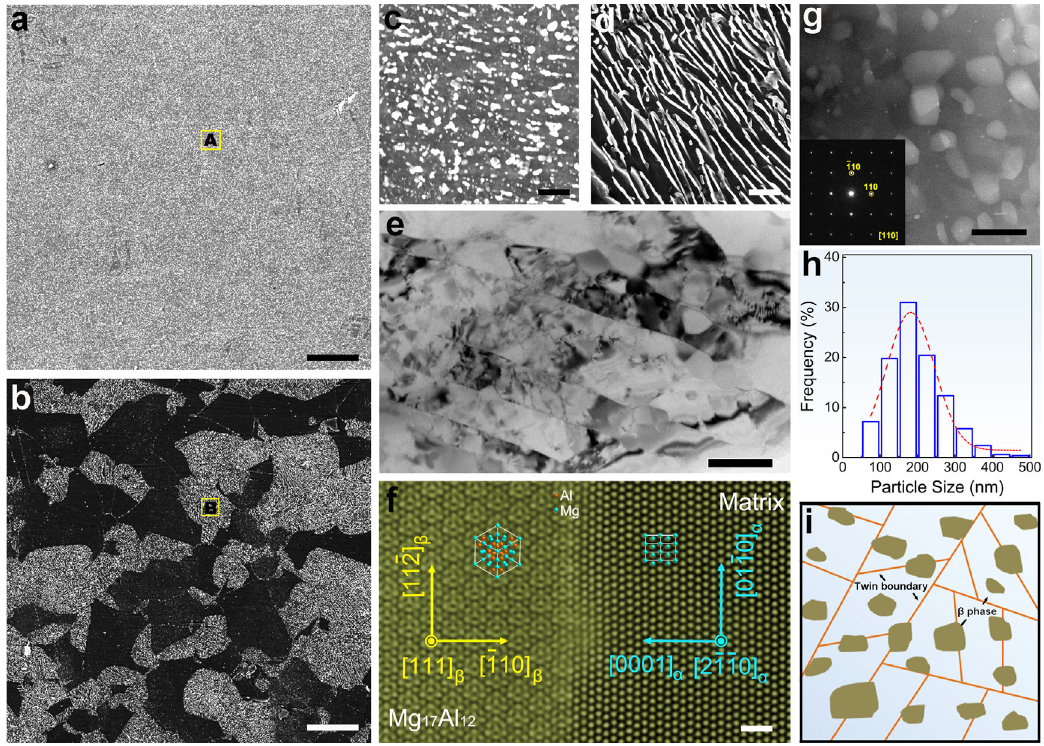
Fig. 2 Microstructure after aging at 180 °C for 24 h. Scanning electron microscopy (SEM) images of ( a ) Aged UFT-4 and ( b ) AZ80-T6, scale bar = 20 μ m in ( a ) and ( b ); ( c ) and ( d ) High-magni fi cation SEM images of regions A and B, scale bar = 2 μ m in ( c ) and ( d ); ( e ) TEM image of aged UFT-4, scale bar = 500 nm; ( f ) atomic resolution HAADF-STEM and ( g ) HAADF-STEM images of the precipitates in aged UFT-4, scale bar = 1 nm in f and scale bar = 500 nm in ( g ); ( h ) Size distribution of the precipitates in aged UFT-4. i Schematic diagram showing the microstructure of aged